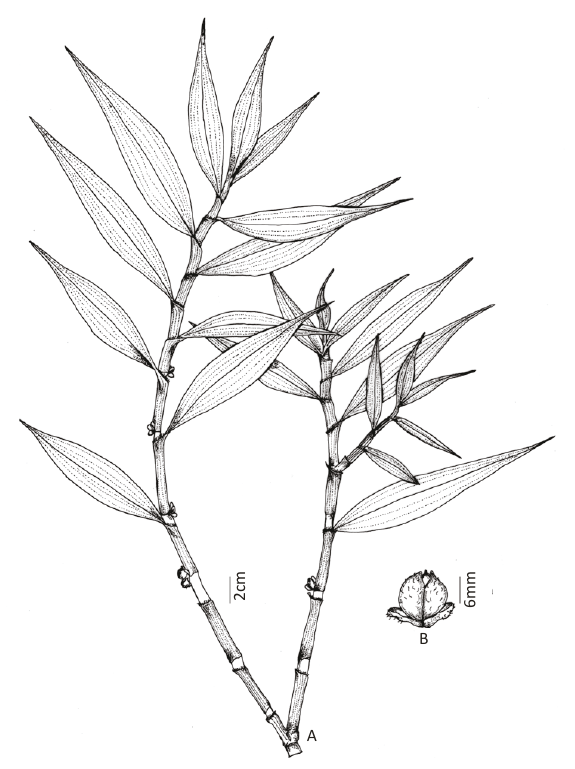
Figure 3. Porandra ramosa D.Y. Hong.